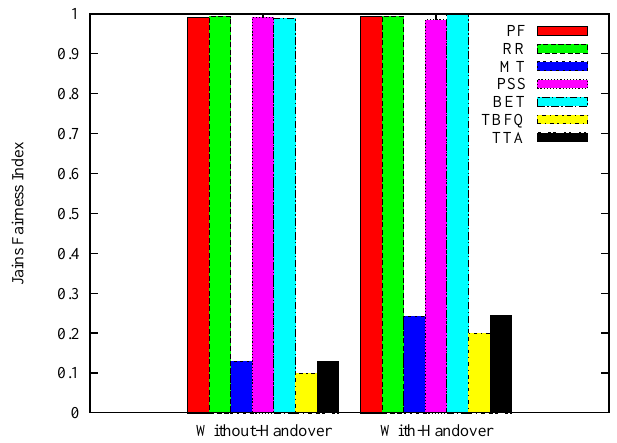
Figure 12. Jains fairness index of different schedulers. Number of UE =